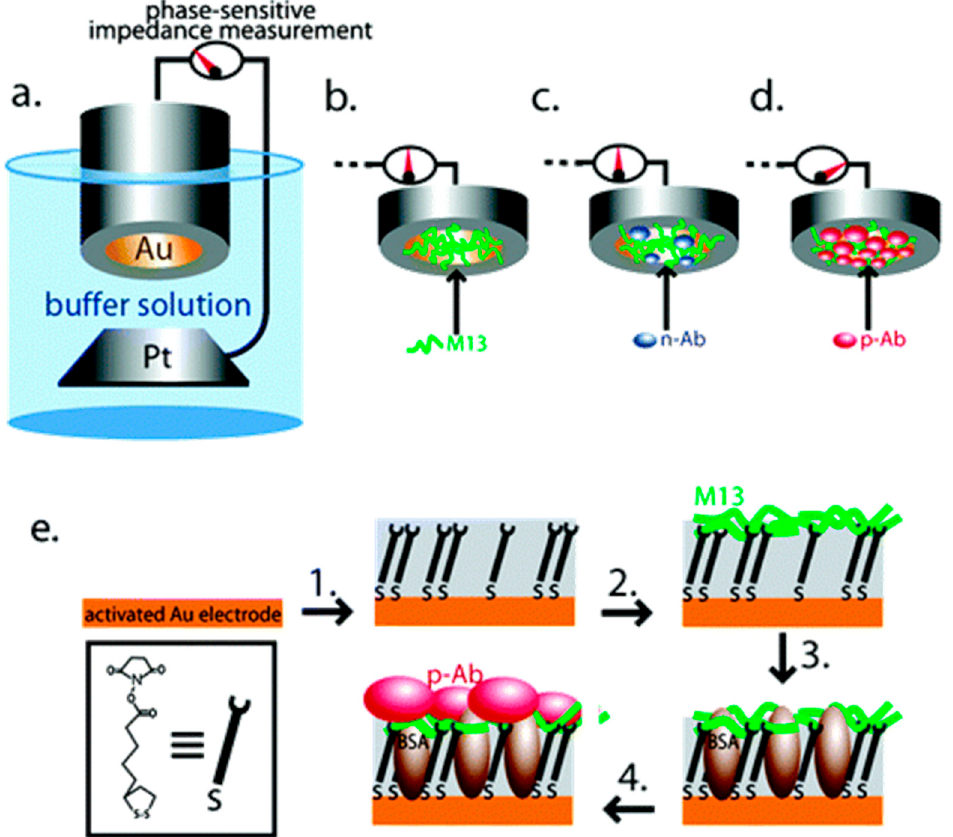
Figure 3. Scheme of a virus-based electrochemical sensor. Scheme of the measuring system ( a ) and reference state of the M13 virus-based electrode ( b ). The surface of a gold electrode is functionalized according to ( e ) 1–3. Sensor response (measured via EIS) is specified to the target—positive antibody, p-Ab ( d )—and is negligible for a non-specific target—negative antibody, n-Ab ( c ). Reprinted with permission from [55]. Copyright 2006 American Chemical Society.